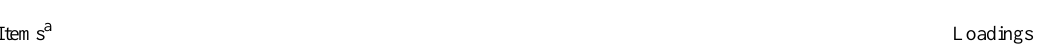
Table 2. Factor loadings of the IAT items and corrected item-total correlations for the one-factor solution.